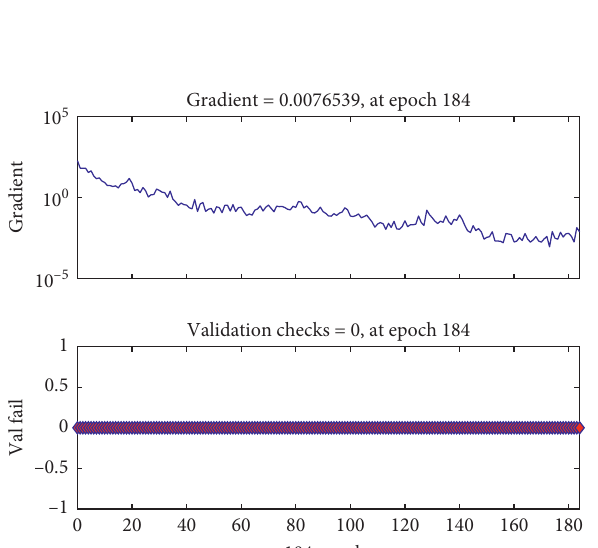
Figure 5: The iteration chart.